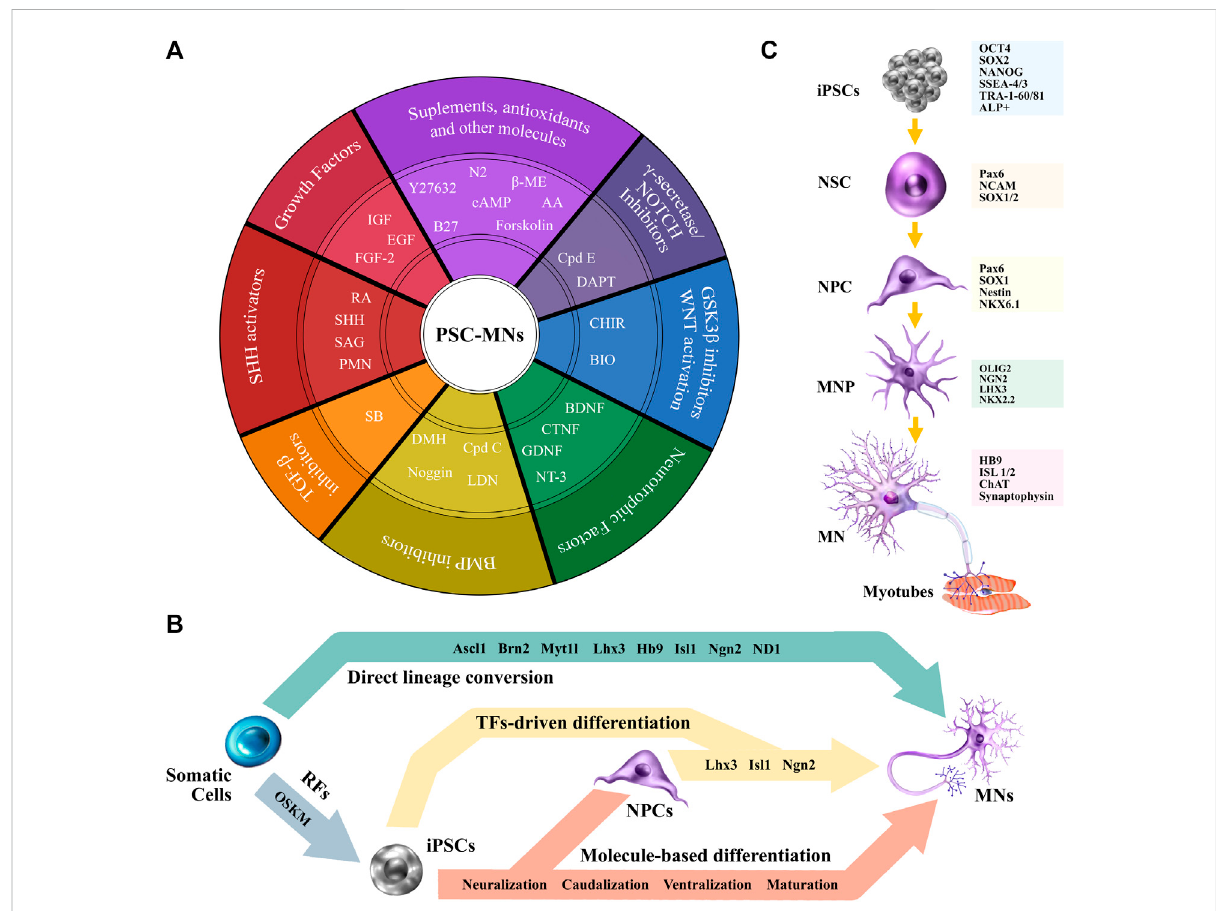
FIGURE 3 From PSCs to MNs. (A) A schematic view of commonly used molecules to differentiate PSCs towards MNs. (B) Differentiation strategies. (C) iPSCs-MN cell markers for characterization. Abbreviations: RFs, reprograming factors; TFs, transcription factors; ß-ME, ß-Mercaptoethanol; AA, ascorbic acid; Cpd E, compound E; cAMP, cyclic adenosine monophosphate; DAPT, N-[(3,5-di fl uorophenyl)acetyl]-l-alanyl-2- phenyl]glycine-1,1- dimethylethyl ester; GSK3, glycogen synthase kinase 3; WNT, wingless/integrated; CHIR, CHIR99021; BIO, (2 ′ Z, 3 ′ E)-6-bromoin-dirubin-3 ′ - oxime; BDNF, brain-derivedneurotrophic factor; CNTF, ciliaryneurotrophic factor; GDNF, glial-derivedneurotrophic factor; NT-3, neurotrophin-3; BMP, bone morphogen protein; Cpd C, compound C; LDN, LDN193189; RA, retinoic acid; DMH, dorsomorphin; SHH, sonic hedgehog; TGF-ß, transforming growth factor-ß; SB, SB431542; SAG, smoothened agonist; IGF, insulin-like growth factor; FGF-2, fi broblast growth factor-2; EGF, epidermal growth factor; PMN,